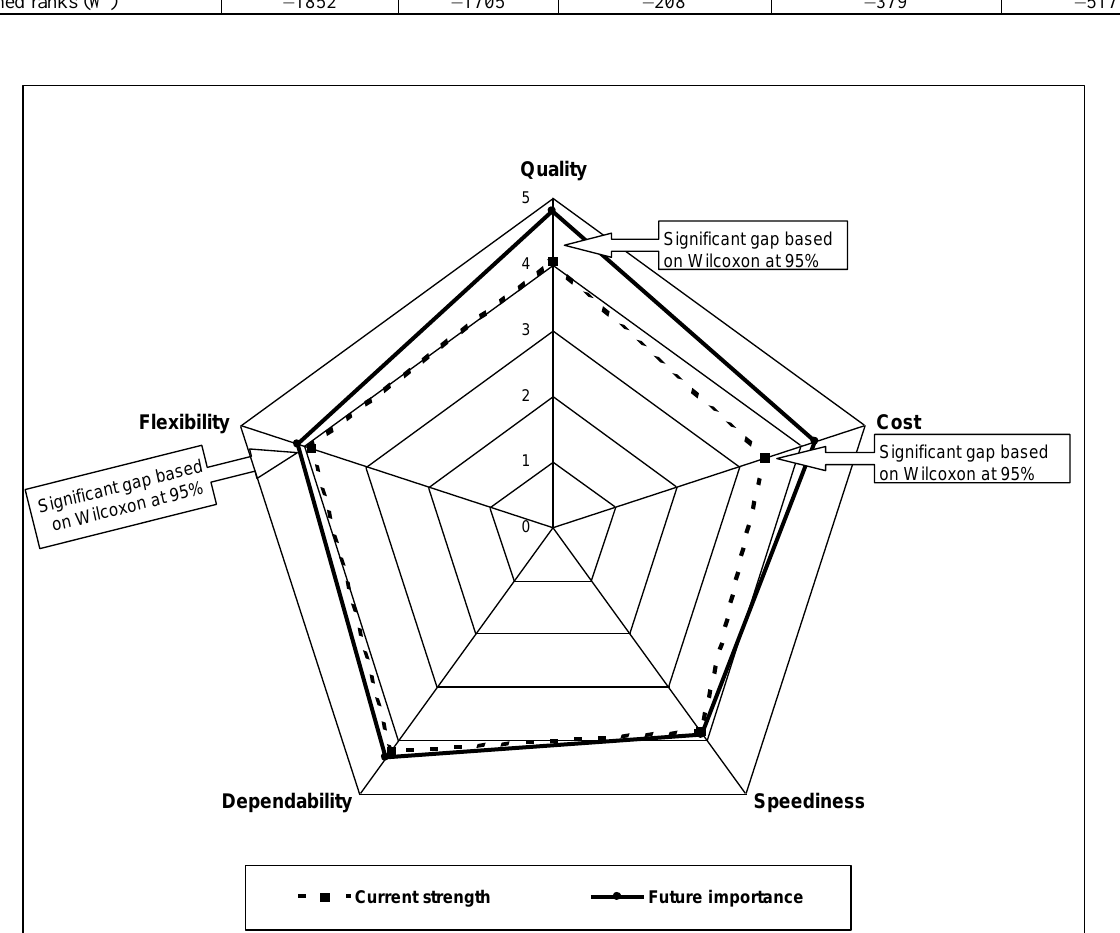
Graph 4: Current strength vs future importance